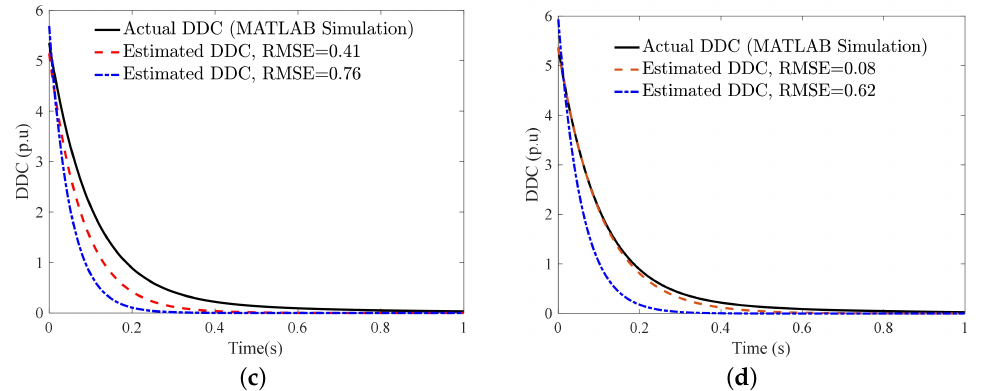
Figure 10. simulation results, methods [12] (red line) and [13] (blue line), under four different cases: ( a ) without noise, ( b ) in the presence of noise, ( c ) 0.5 Hz frequency deviation, ( d ) in the presence of the second